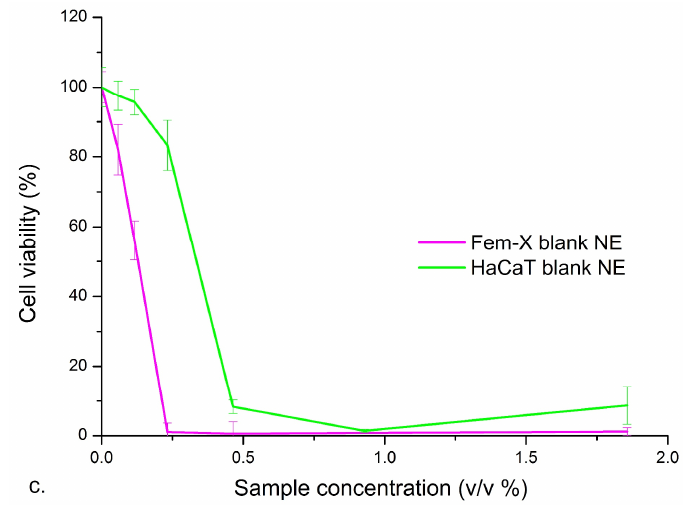
Figure 6. Cell viability percentage depending on the sample concentration: ( a ) effect of the raw mate- rials and the corresponding nanoemulsions on malignant Fem-X cell line, ( b ) effect of raw materials and the corresponding nanoemulsions on normal HaCaT cells, ( c ) effect of blank nanoemulsions on malignant Fem-X and normal HaCaT cells. Each experiment was repeated three times and the results were presented as the mean value ±